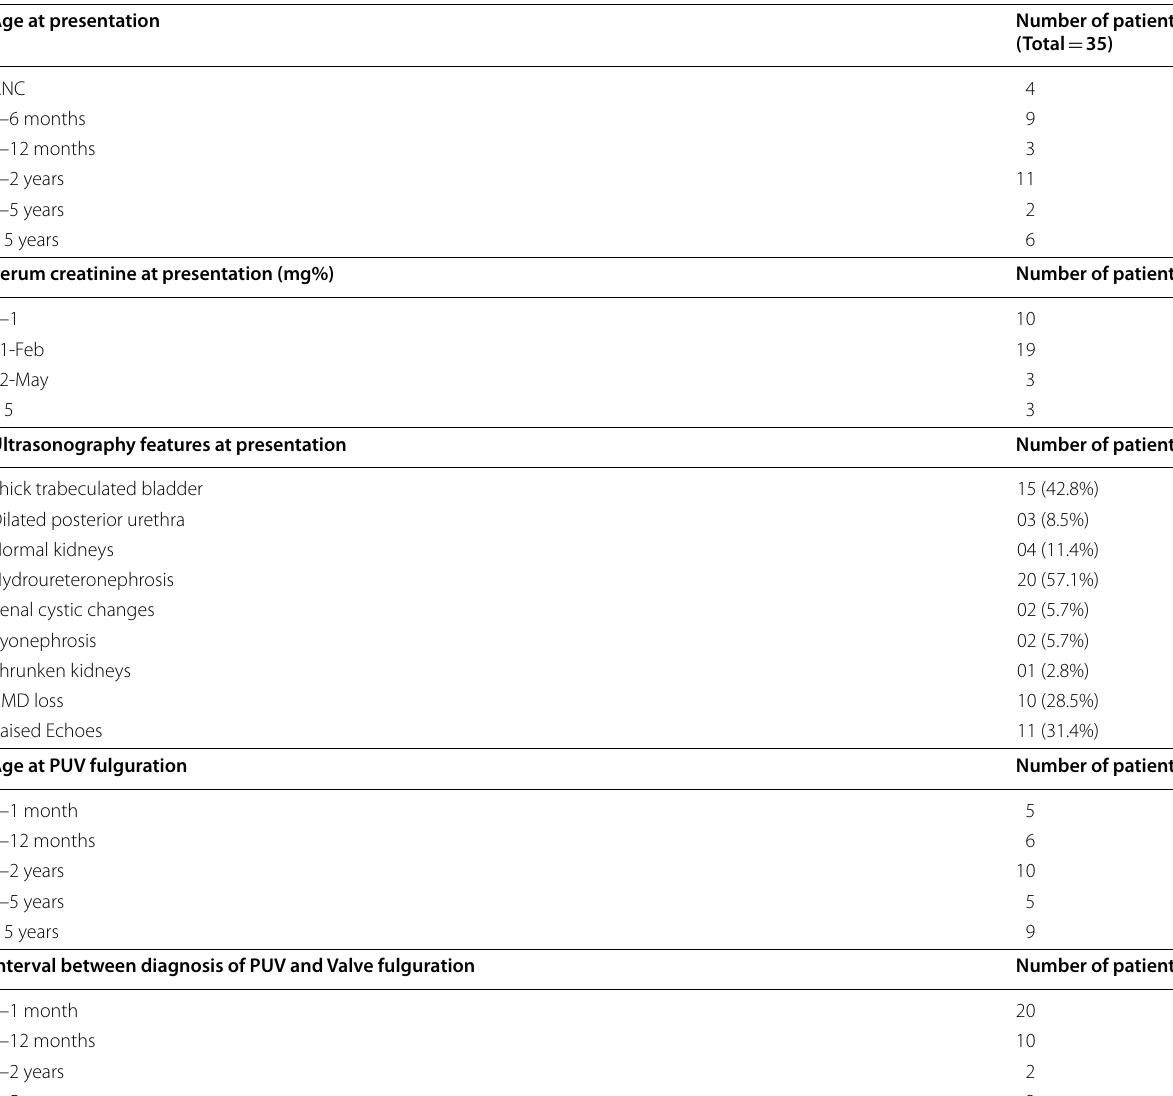
Table 1 Characteristics of